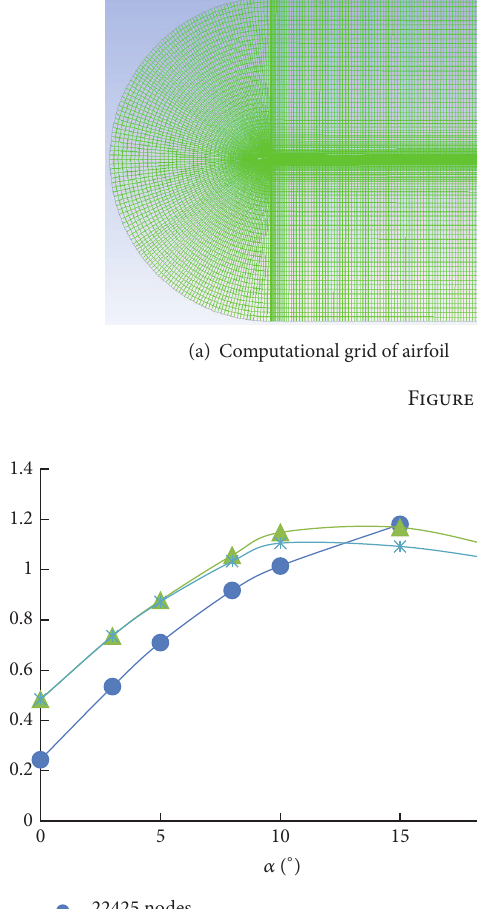
domains and boundary conditions are shown in Figure